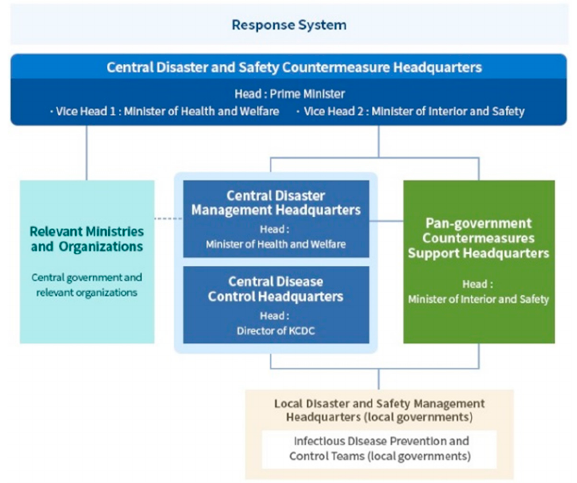
Figure 3. Korean government’s response system. (Central Disease Control Headquarters; National Control